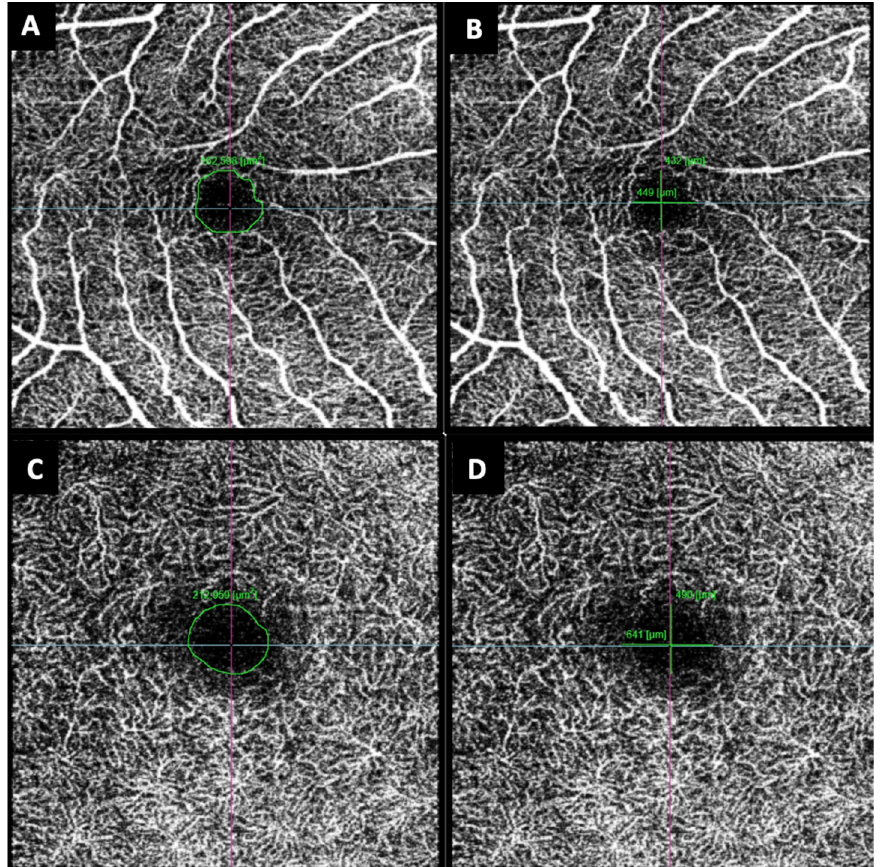
Figure 2. Example of foveal avascular zone (FAZ) area and diameters measured manually in both superficial (SCP) and deep capillary retinal plexuses (DCP). ( A ) FAZ area of the SCP. ( B ) FAZ diameter of the SCP. ( C ) FAZ area of the DCP. ( D ) FAZ diameter of the DCP.